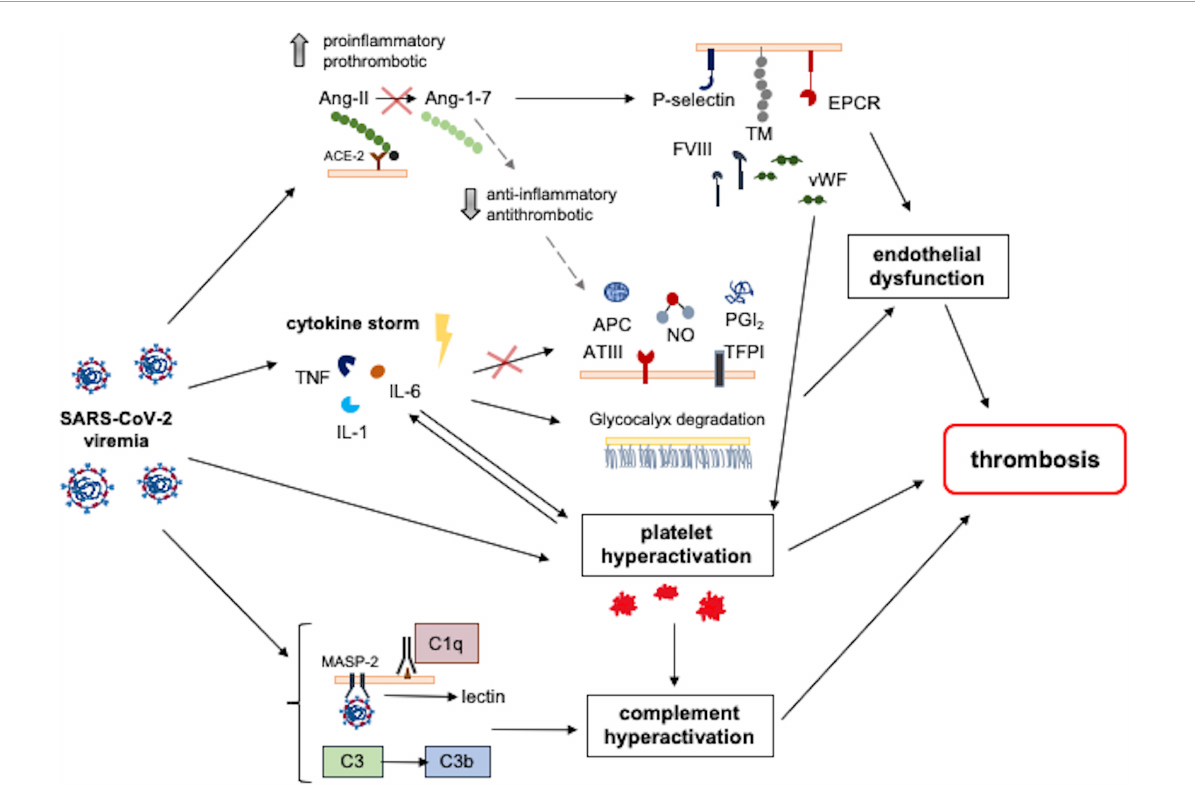
FIGURE5 Pathomechanisms involved in SARS-CoV-2-induced thrombosis. Different SARS-CoV-2-induced pathways converge and result in a prothrombotic state. SARS-CoV-2 binding with the ACE2 receptor reduces its activity, increasing Ang2 levels and resulting in increased proinflammatory and prothrombotic signals. These signals mediate endothelial dysfunction and platelet hyperactivation, which is also directly induced by SARS-CoV-2 infection. Contemporary, the hyperinflammatory state induced by SARS-CoV-2 infection contributes to endothelial dysfunction following the reduction of antithrombotic factors and the degradation of glycocalyx. Moreover, SARS-CoV-2 induces complement hyperactivation, resulting in endothelial damage, platelet hyperactivation, and thrombosis. ACE2, angiotensin-converting enzyme 2; Ang, angiotensin; APC, activated protein C; ATIII, antithrombin III; EPCR, endothelial protein C receptor; FVIII, factor VIII; IL-1, interleukin 1; IL-6, interleukin 6; MASP-2, mannose-binding lectin-associated serine protease; NO, nitric oxide; PGI 2 , prostacyclin; TFPI, tissue factor pathway inhibitor; TM, thrombomodulin; TNF, tumor necrosis factor; vWF, von Willebrand